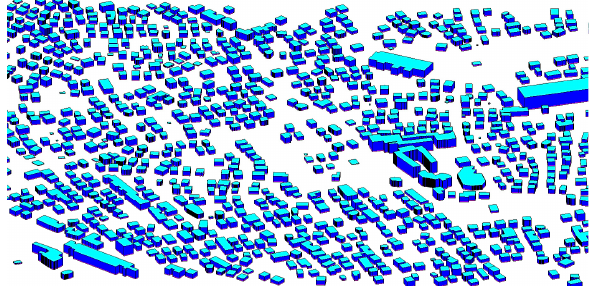
Figure 10: 3D prismatic models